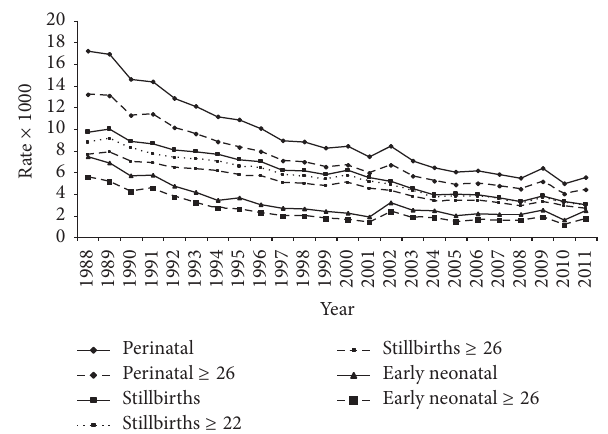
Figure 1: Yearly stillbirth and early neonatal and perinatal mortality rates ( × 1000) for total deliveries and gestations ≥ 22 and ≥ 26 weeks. Period 1996–2009: values of gestations ≥ 26 weeks estimated by linear regression on the total rates (corrected R 2 = 0.998, 0.986 and 0.992,resp.,foreachtypeofmortality).Forstillbirths,alsogestations ≥ 22 weeks estimated by linear regression on the total rate (corrected R 2 =